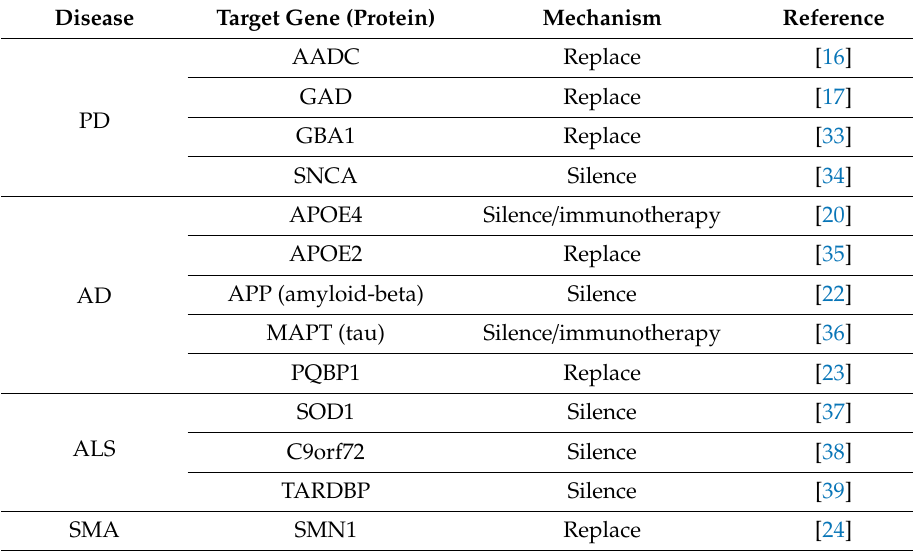
Table 2. Gene therapy strategies and therapeutic e ff ects for major CNS